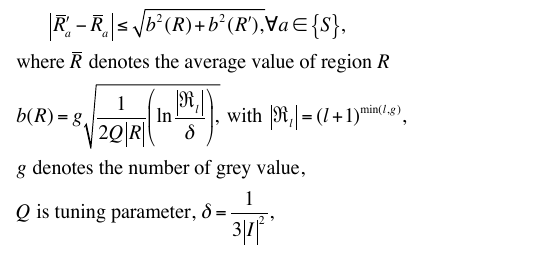
Figure 1. Coarse level